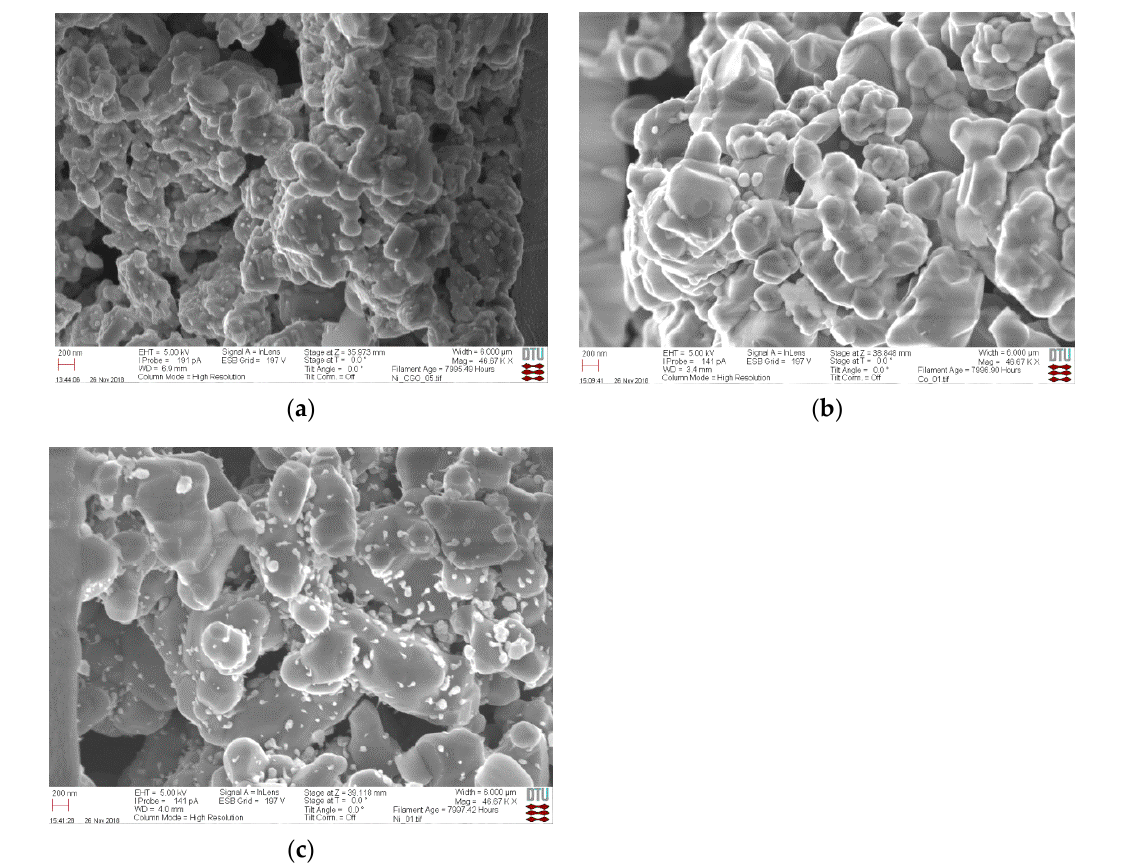
Figure 3. Cross-sectional micrographs of infiltrated symmetrical cells of LSCTZ5 after testing: ( a ) Ni-CGO-infiltrated LSCTZ5, ( b ) Co-infiltrated LSCTZ5, and ( c ) Fe-infiltrated LSCTZ5. Table 1. Average weight gain and weight gain percentage after infiltration.